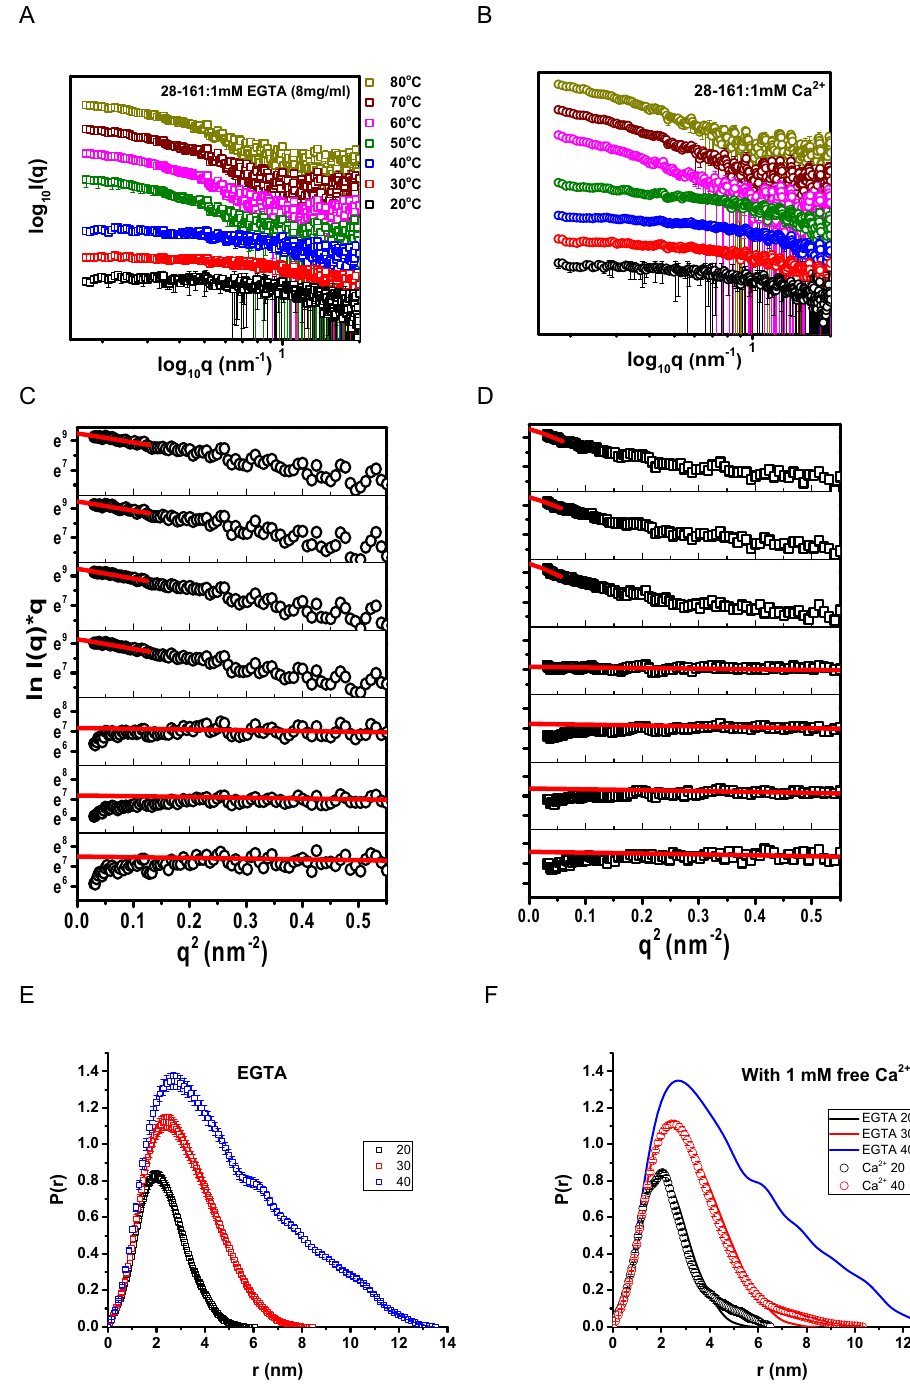
Figure 2. ( A , B ) The intensity plots of SAXS data collected as a function of temperature in absence or presence of 1 mM free Ca 2 + ions are presented here. ( C , D ) Guinier analyses for rod-like shape of the SAXS datasets shown above are presented here. The red lines represent the linear range of the approximation. ( E , F ) The calculated P(r) curves from the SAXS datasets indicating monodisperse nature are plotted